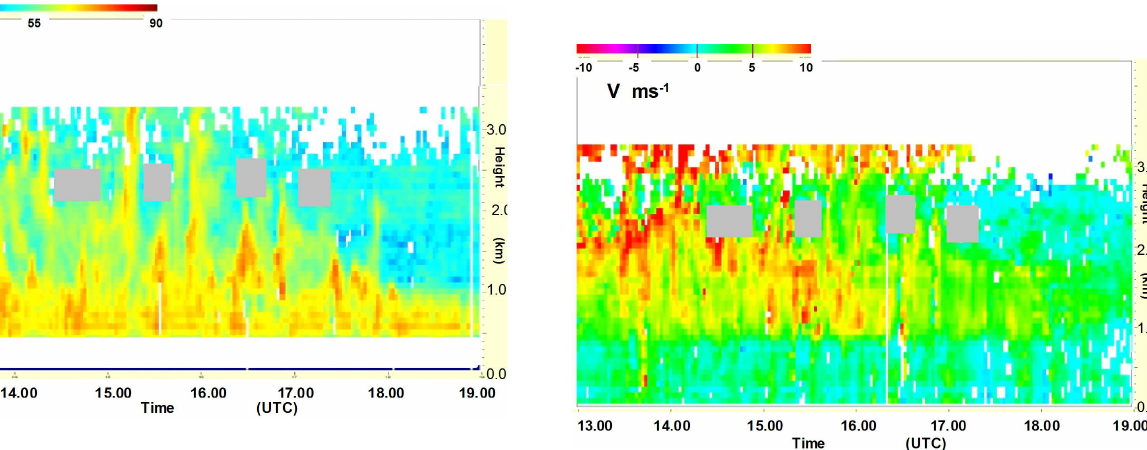
Fig. 13c. Wind V component measured by the wind profiler at Linkenholt 29 June 2005, 13:00 to 19:00UTC from 75 to 3250m a.g.l., doubtful measurements are greyed